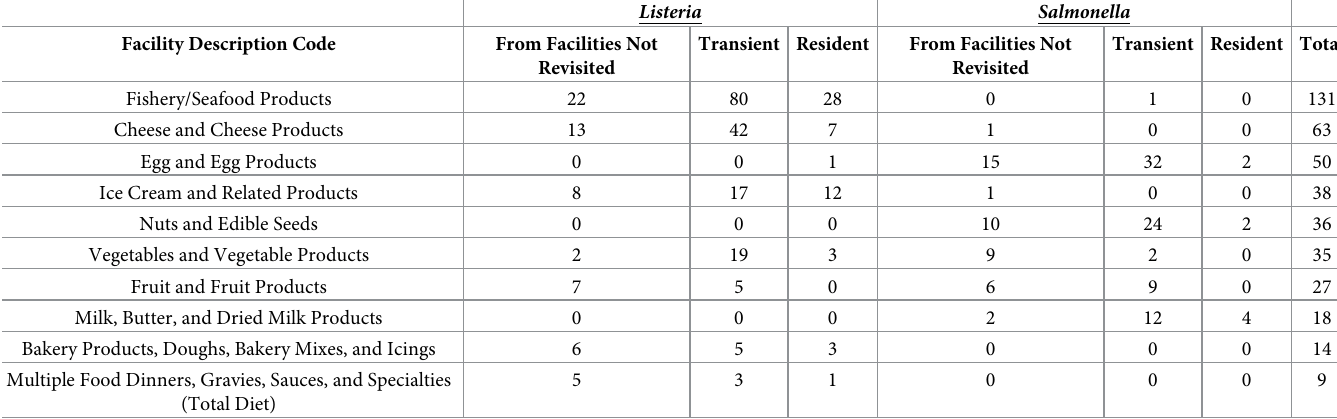
Table 4. The number of strain types among the top 10 most abundant facility description code types. Facilities assigned multiple description code types were